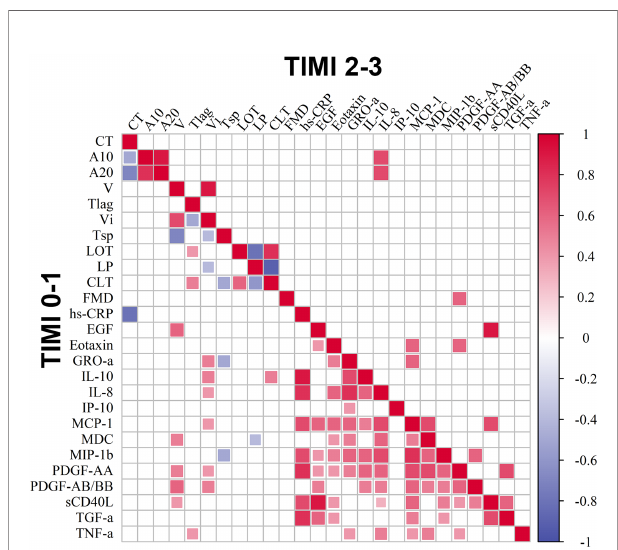
FIGURE 3 | Correlation matrix of circulating markers of in fl ammation, clot formation and endogenous fi brinolysis and FMD. Included are 14 cytokines, hs- CRP, FMD and clot formation and endogenous fi brinolysis parameters in groups of patients with TIMI 0-1 and TIMI 2-3 blood fl ow, p < 0.05, p .adj <